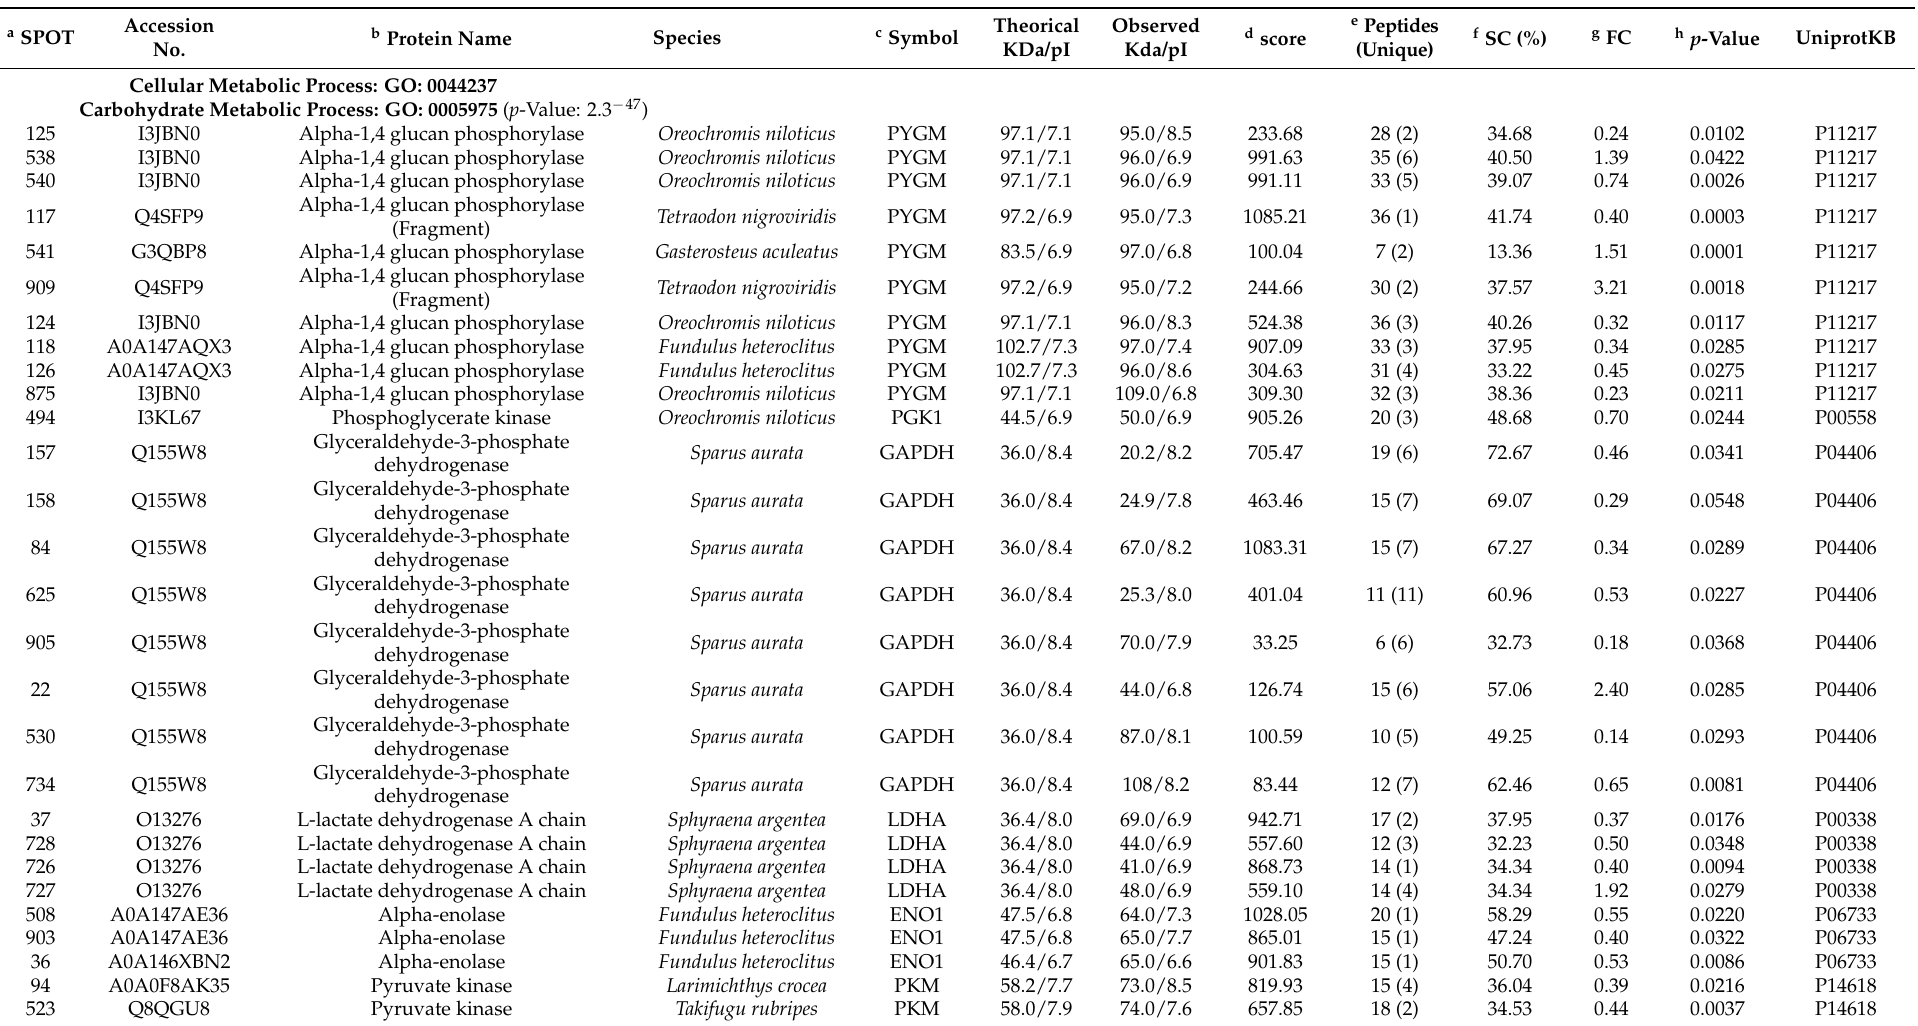
Table 5. Identification of the 37 differentially expressed proteins of white muscle after 9 weeks of rBGH injection on gilthead sea bream